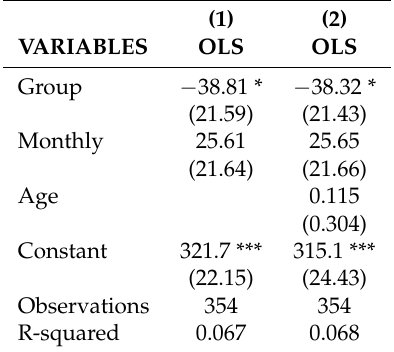
Table 5. Effect of Offering Group Insurance on the Amount of Insurance Purchased.